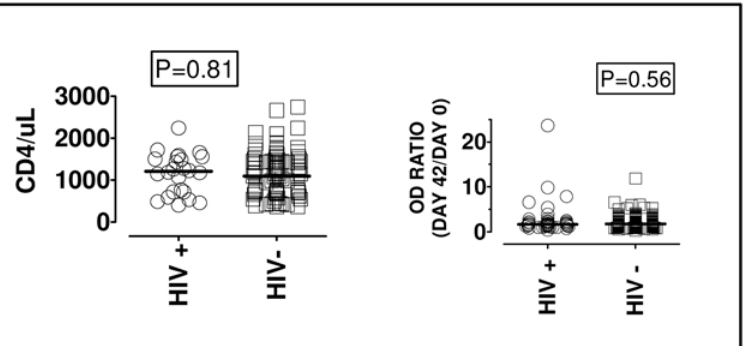
Fig 5. Effect of CD4+ cell count and HIV status on post-infection immune memory increase of anti-P. falciparum IgG. To evaluate the effect of CD4 + cell count and HIV status on post-infection increase of P . falciparum specific antibody, the CD4 + cell counts of PLWHAs (n = 24) and HIV negative participants (n = 91) were first determined. There was no significant difference found in CD4 + cell counts of HIV negative and PLWHAs (p: 0.81, Mann Whitney test). Medians of the respective ratios for summative ELISA OD (as in Fig 4) of day 42 and day 0 sera from PLWHAs and HIV negative participants were likewise not significantly different (Mann Whitney test, p: